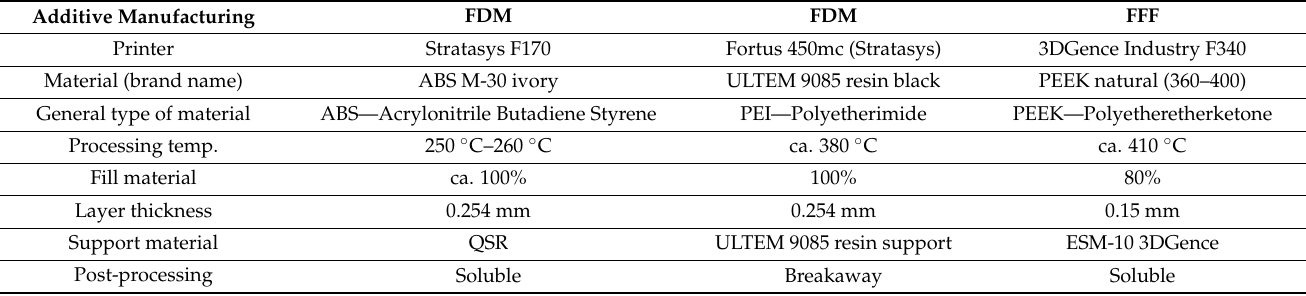
Table 3. Information of prints made using additive